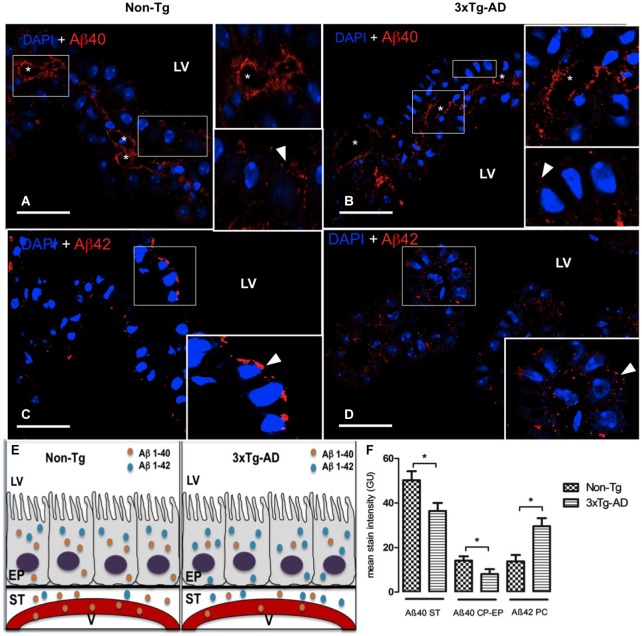
Choroid plexus (CP) confocal microscopy images immunolabeled from Non-Tg (A,C) and 3xTg-AD mice (B,D) stained with anti-Aβ40 (A,B) and anti-Aβ42 (C,D). The asterisks show the blood vessels staining and arrowheads show the cytoplasmic staining of CP epithelial cells (CP-EP) of lateral ventricle (LV). According to figure (see also the results in text) in the left bottom (E) is also shown a scheme about the distribution of Aβ40 and Aβ42 in vessels (V), stroma (ST) and epithelial cells (EP) of 3xTg-AD compared to Non-Tg mice. On the right bottom (F) are presented values of stain intensitites for Aβ40 and Aβ42 as the means ± SEM; n = eight animals per group; * p < 0.01 3xTg-AD vs. Non-Tg mice. Scale bars, 30 μm.